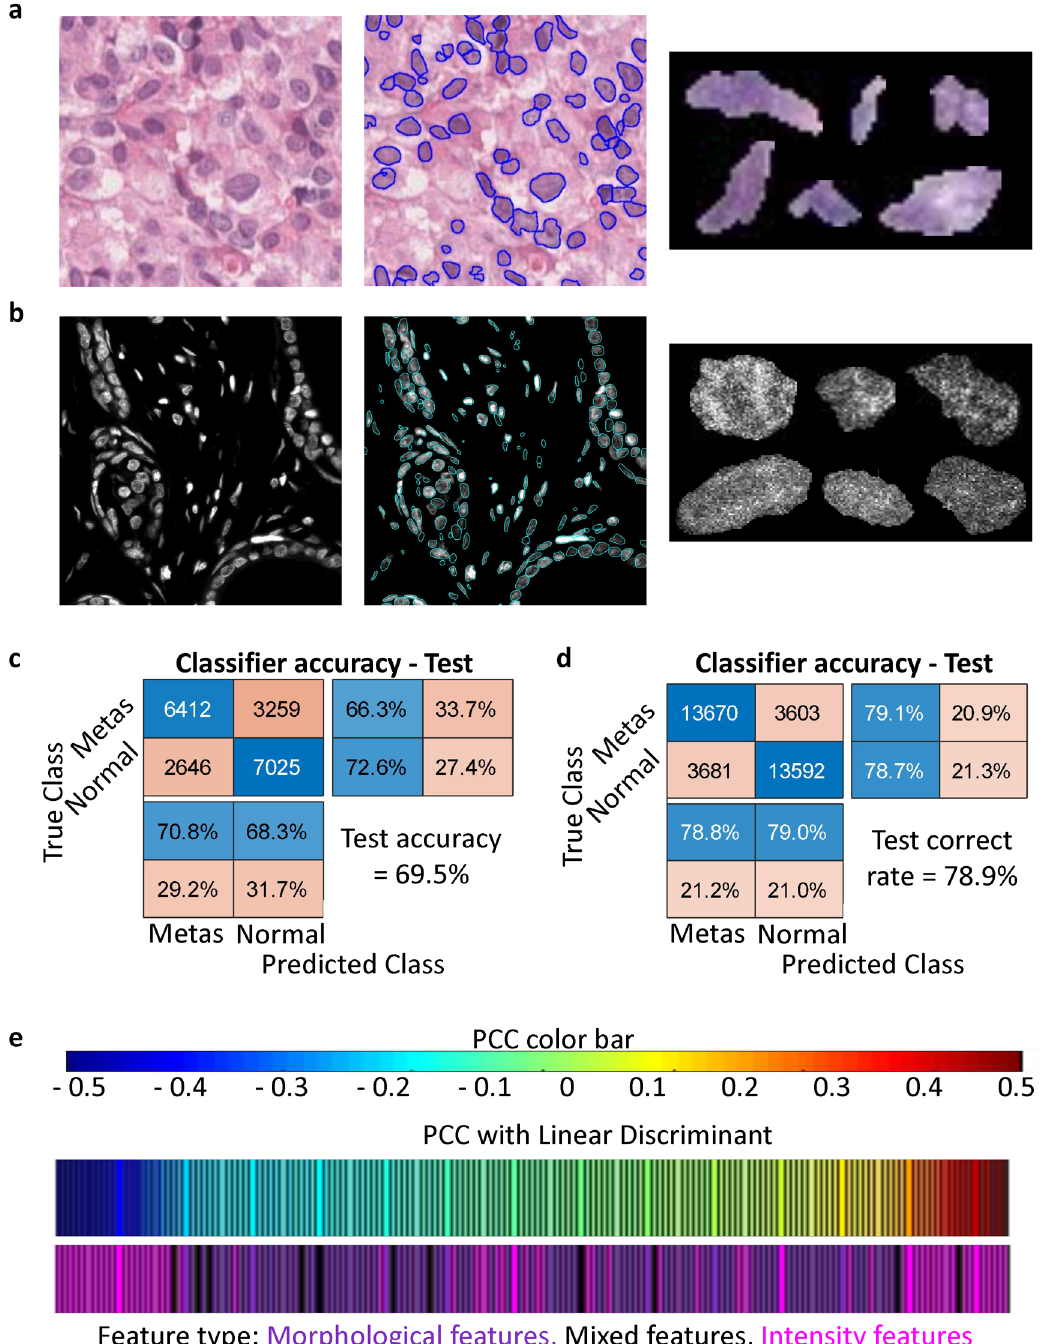
Figure 2. Hoescht staining improves the sensitivity to discriminate tumor progression. Representative crop of an H&E-stained ( a ) and Hoescht stained ( b ) tissue biopsy image (left). Marked in blue are the regions detected as nuclei for downstream segmentation and analysis. Representative crops of individual nuclei segmented are shown on the right side. Confusion matrices depicting the performances of the linear discriminant classifier in classifying nuclei from normal and metastatic tissues according to their nuclear features in H&E-stained tissues ( c ) and Hoescht stained tissues ( d ). ( e ) Correlation between nuclear features and the linear discriminant axis for the Hoescht-stained nuclei. The features have been colour-coded and grouped into morphological features, mixed features and intensity